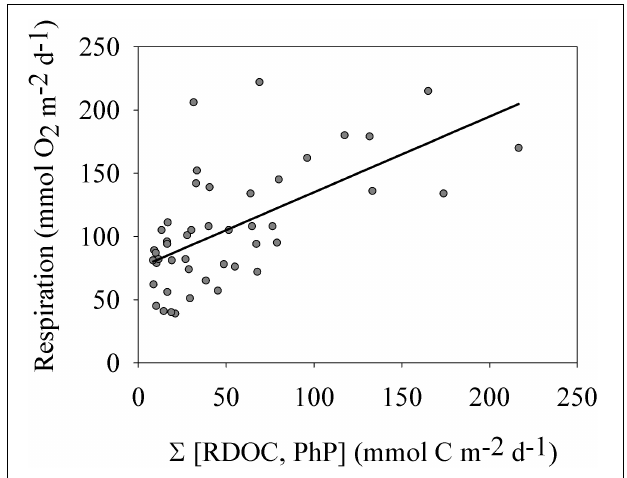
FIGURE 4 | Plankton respiration vs. the sum of phytoplankton production and river inflow of riverine organic carbon (RTOC). The linear relationship was significant ( p < 0.001 and r 2 = 0.38). See section “Results” for more